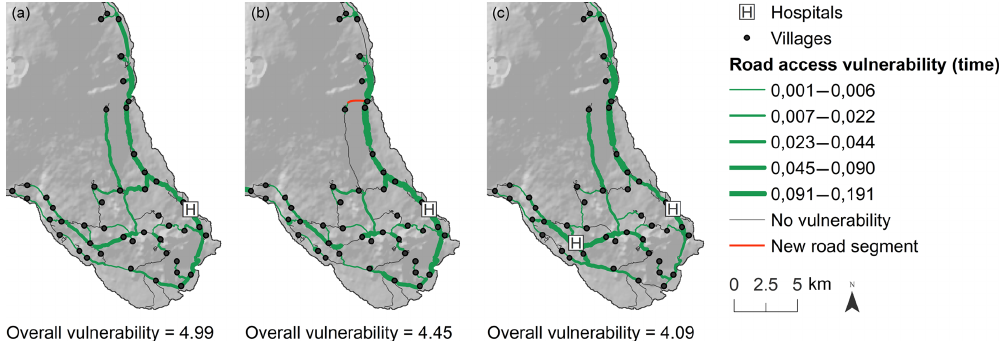
Figure 10. Modification of the actual road access vulnerability (a) by constructing a new road segment (b) or by developing a new infrastruc- ture (c) . The overall road access vulnerability is the sum of the road access vulnerability values of all road segments within the Foumbouni hospital service area.